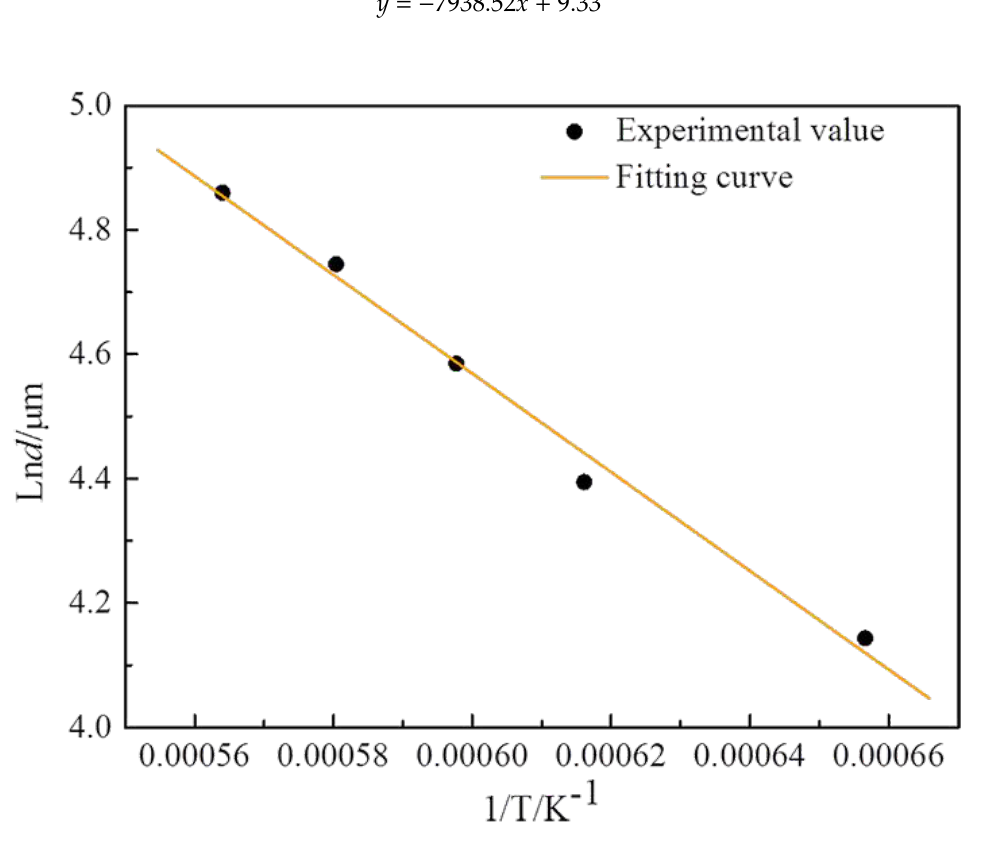
Figure 14. The relationship between ln d and 1/ T.